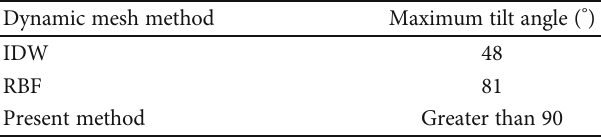
Table 1: Comparison on deformation ability. Dynamic mesh